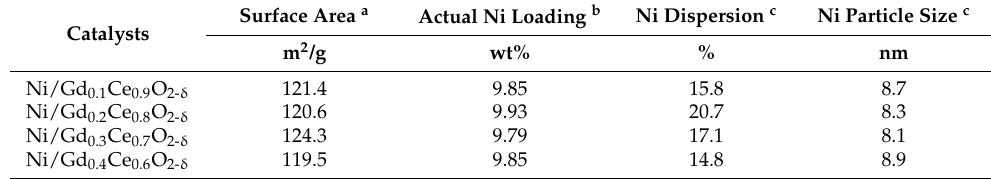
Table 2. The textural properties of the